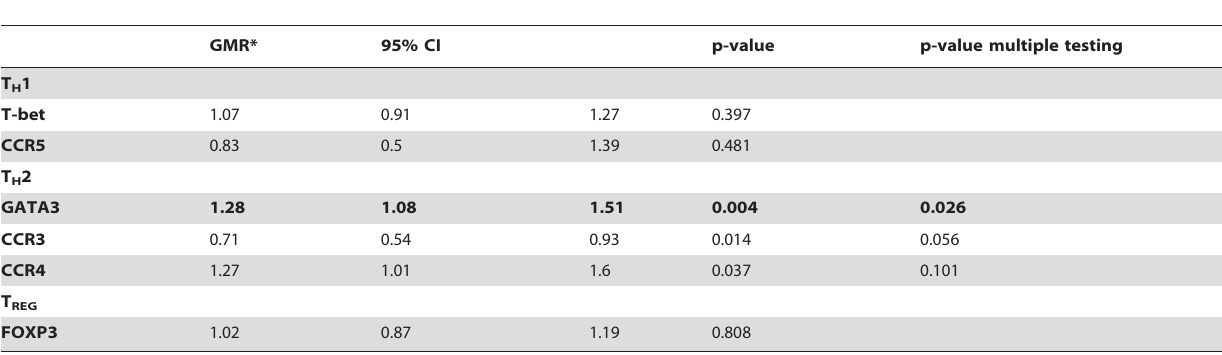
Table 4. Association of farm life with gene expression of markers of T helper cell subtypes.